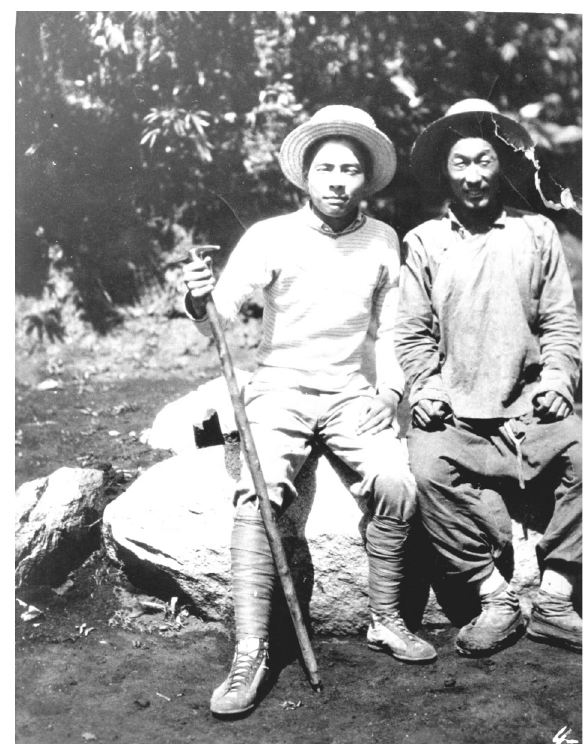
Figure 3. Mr. Xitao Cai (left) on the fi eld trip to Nujiang Prefecture of Yunnan